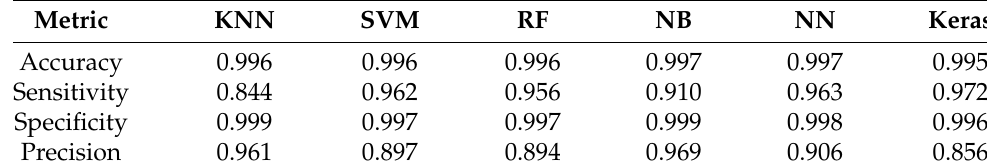
Table 3. Metrics comparing automatic and manual classification.